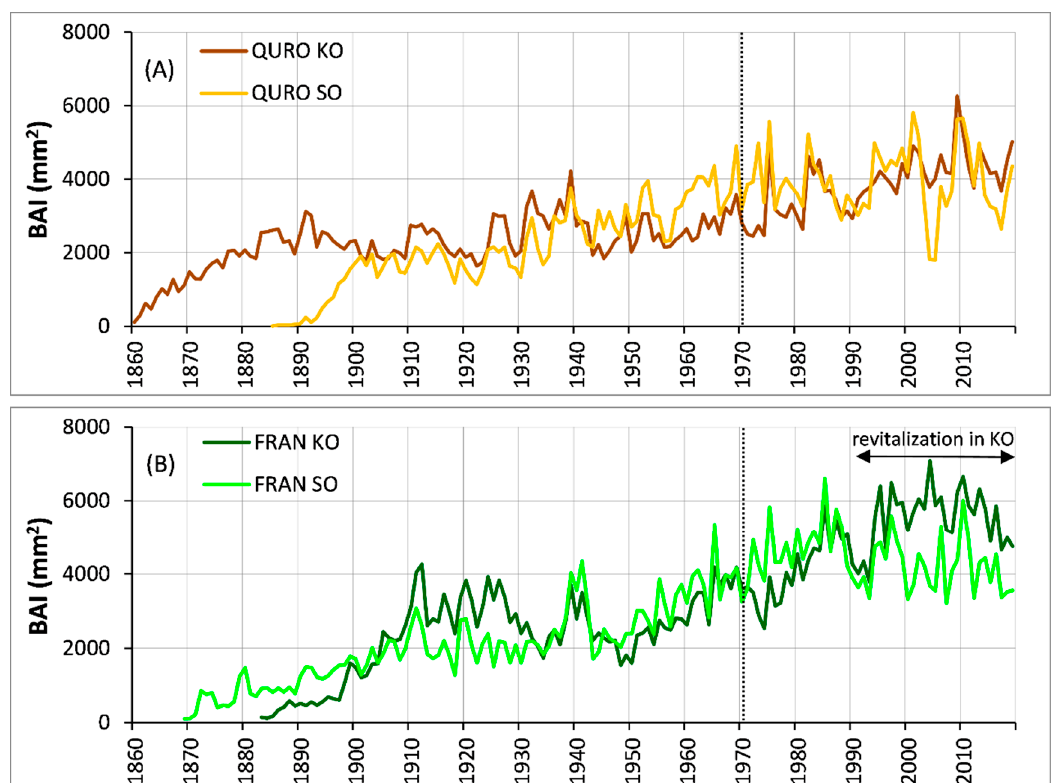
Figure 6. Basal increment area chronologies for: ( A ) Quercus robur , ( B ) Fraxinus angustifolia at KO and SO sites. The dotted line shows the date when the river regulation started and the double-ended arrow delimits when revitalization occurred at KO. Table 2. Slopes of linear fits for RWI100 chronologies (1900–2019, 1972–2019). Significant values are in bold ( p -values are in